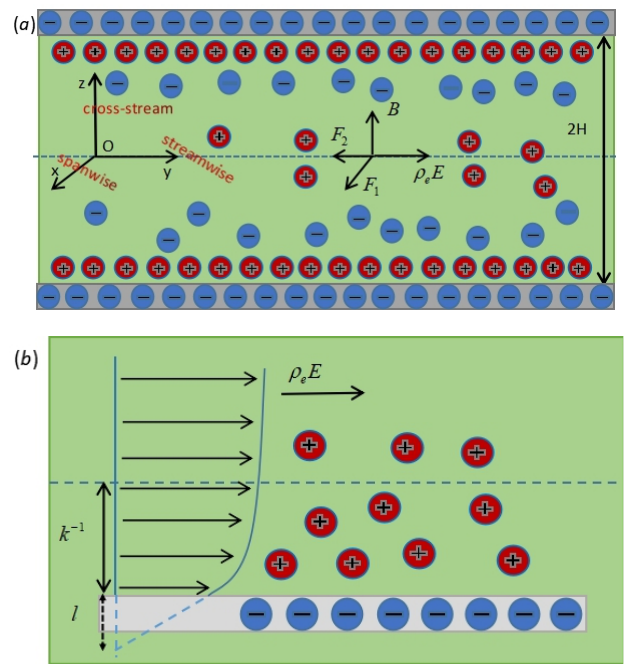
Figure 1. ( a ) Sketch of EMHD flow with EDL effect in parallel microchannels. ( b ) Sketch of the slip length at the wall, where l is the distance inside the wall where the fluid velocity would extrapolate to zero and k − 1 is the thickness of the electric double